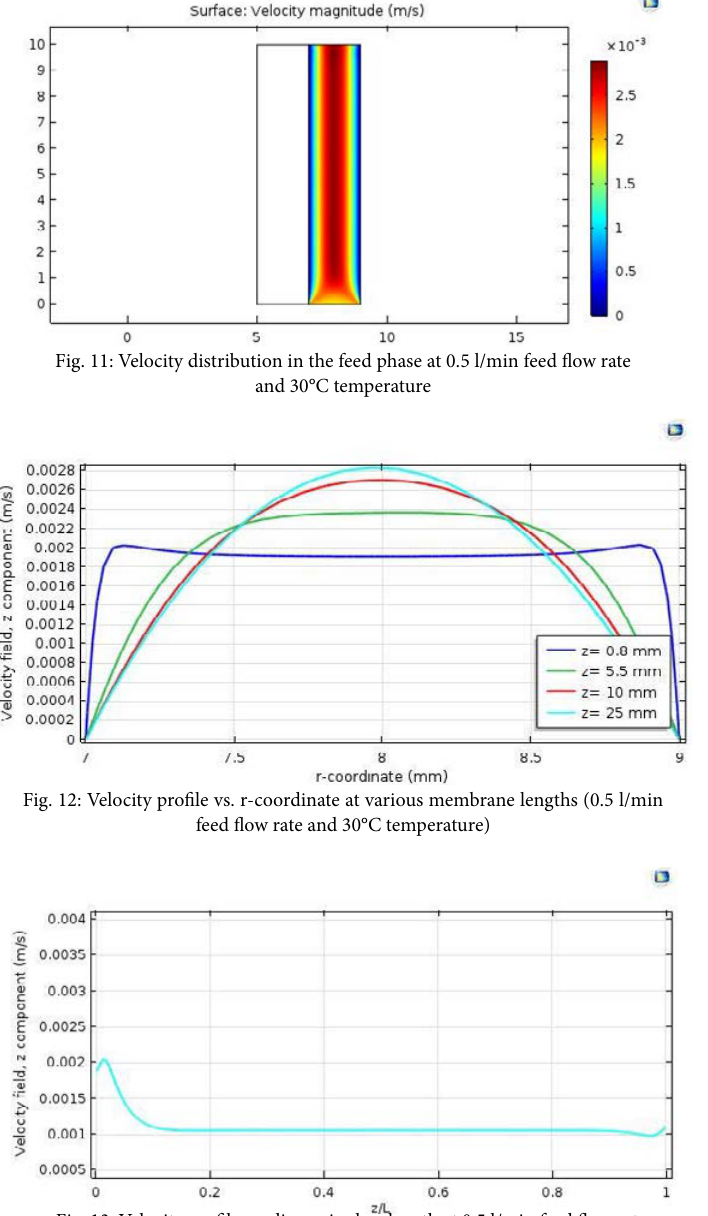
Fig. 13: Velocity profile vs. dimensionless length at 0.5 l/min feed flow